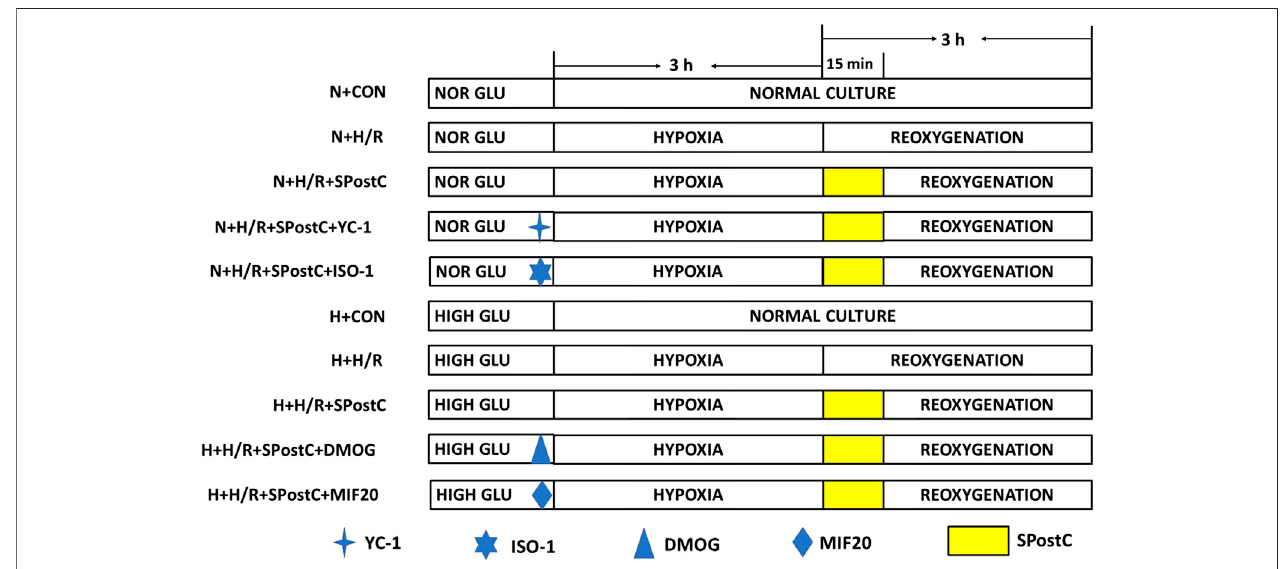
FIGURE 1 | Experimental groups with respective protocols. H9c2 cardiomyocytes were randomly divided into N + CON, N + H/R, N + H/R + SPostC, N + H/R + SPostC + YC-1, N + H/R + SPostC + ISO-1, H + CON, H + H/R, H + H/R + SPostC, H + H/R + SPostC + DMOG and H + H/R + SPostC + MIF20 groups.